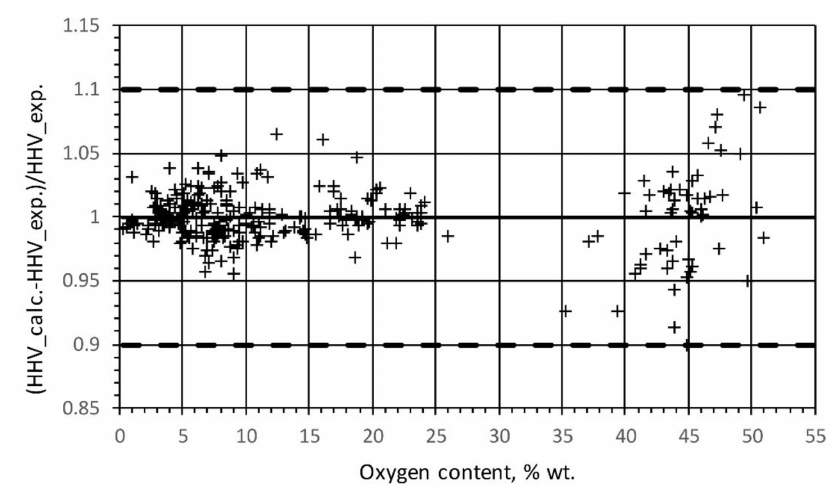
Figure 7. Prediction of HHV with a proposed